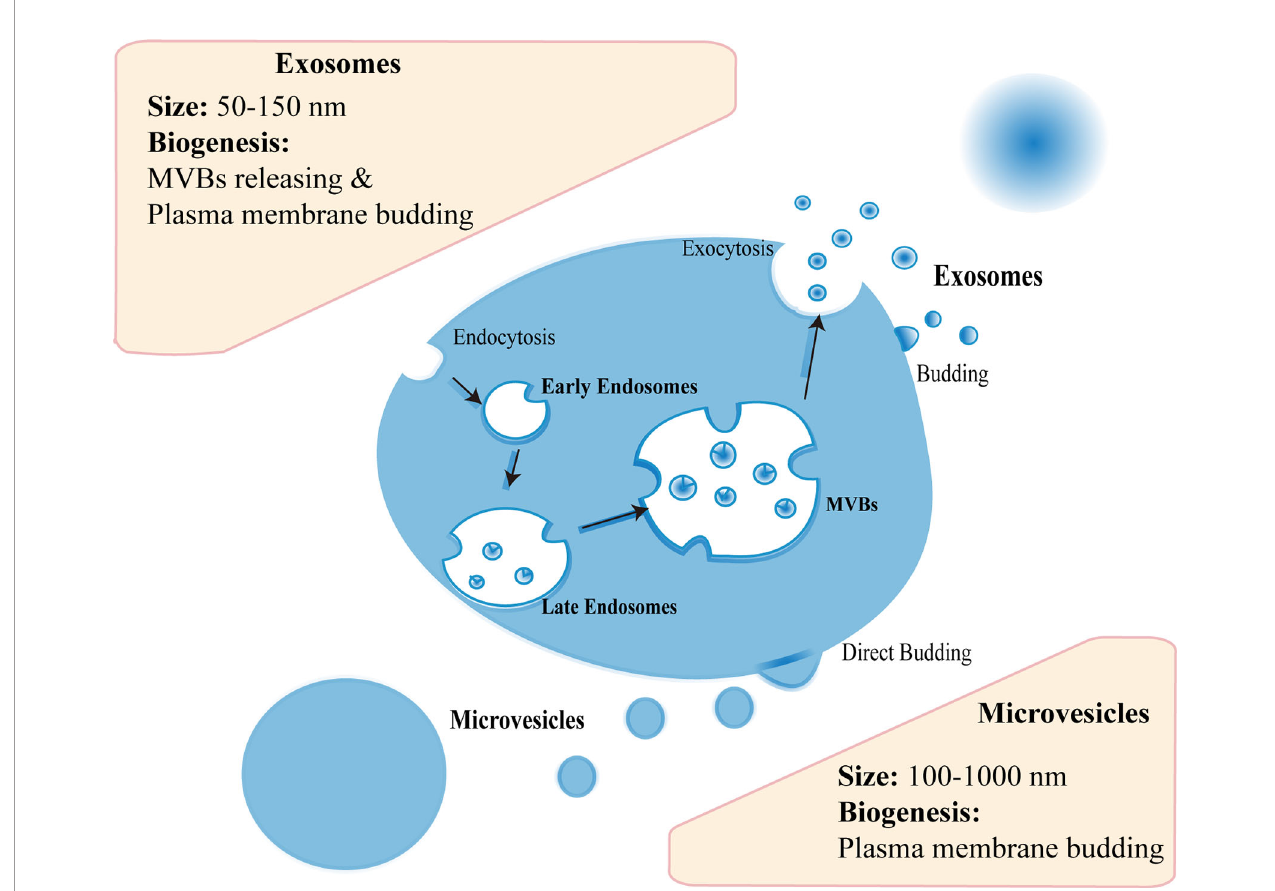
FIGURE 1 | The biogenesis of extracellular vesicles. Exosomes are released upon fusion of MVBs with cell membrane or originate in cell membrane protrusions. Microvesicles bud from the plasma